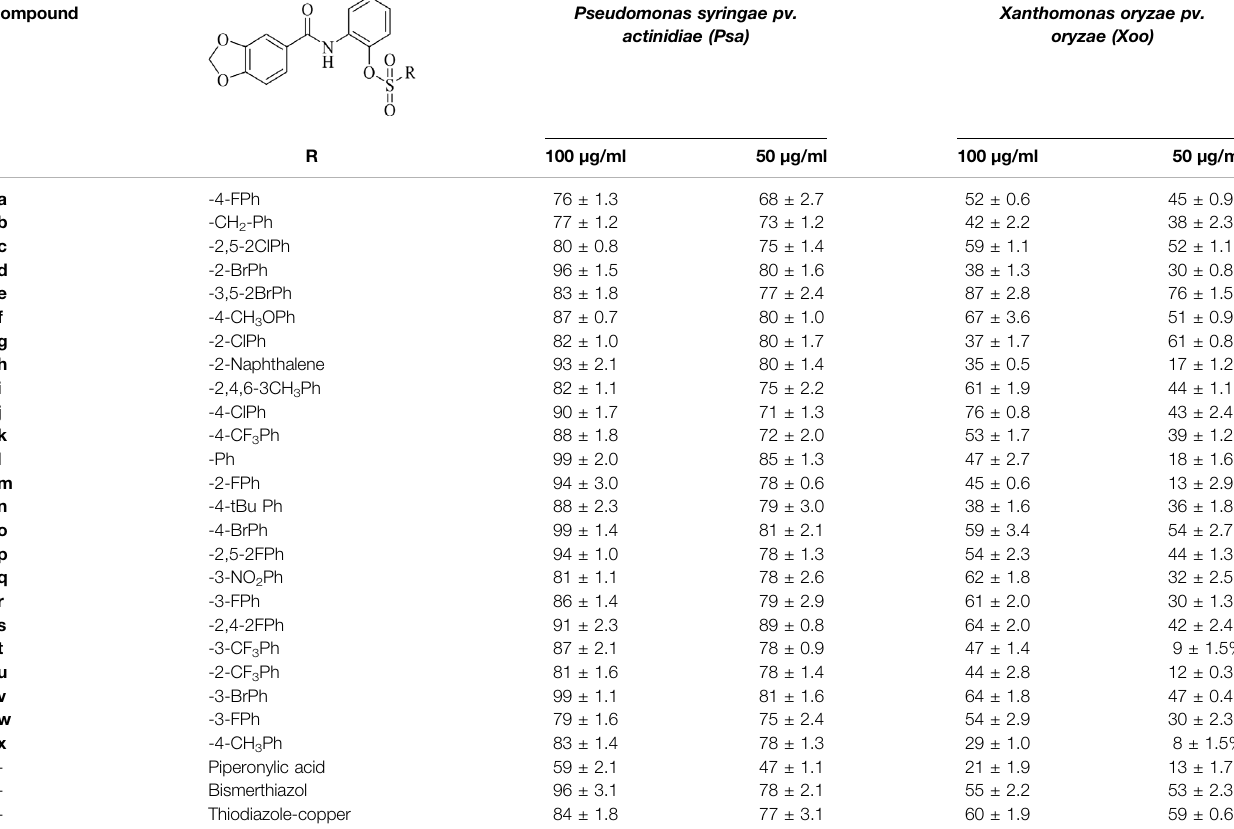
TABLE 1 | In vitro antibacterial activities of the target compounds 4a – 4x .